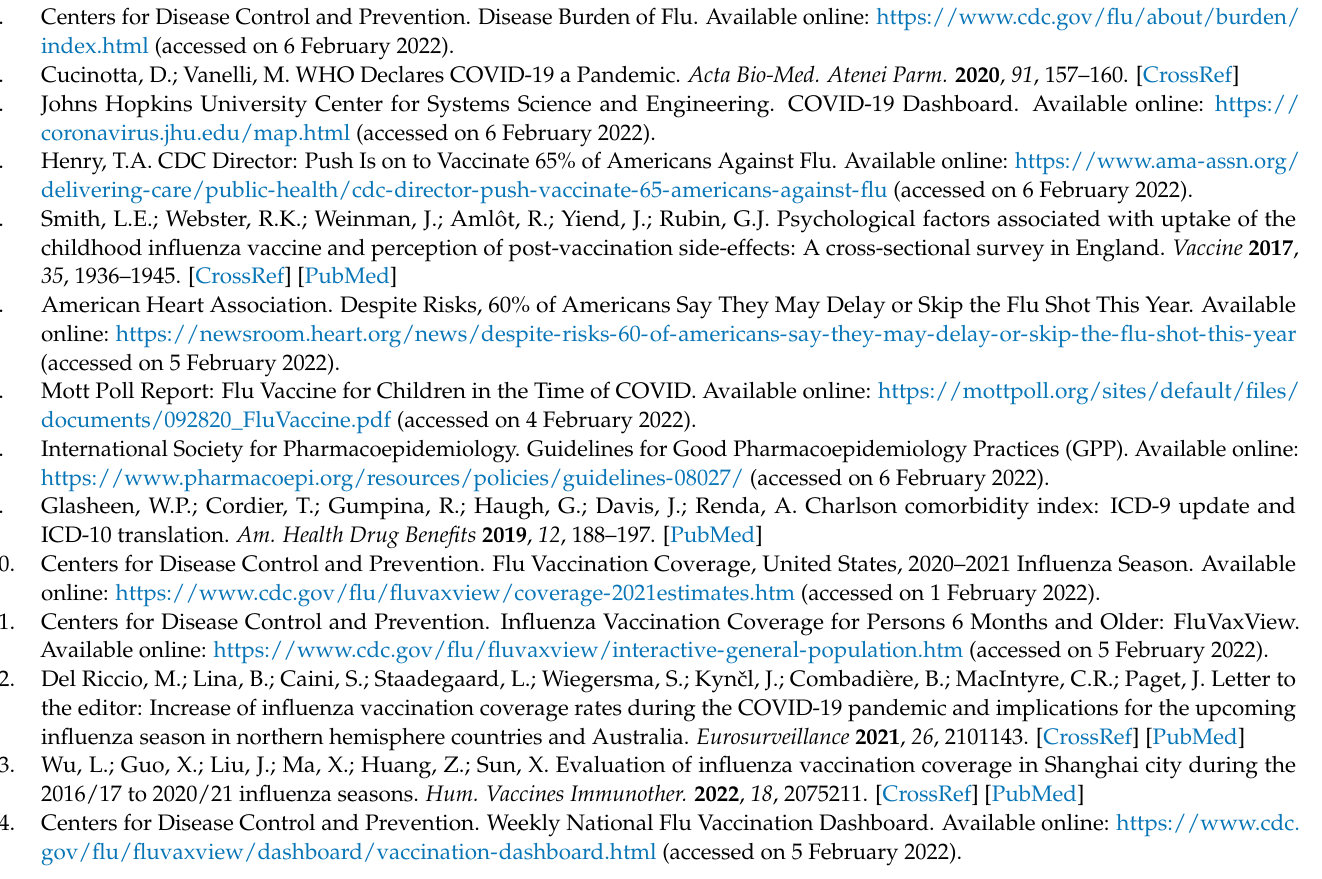
Table S9: Demographic and clinical characteristics of individuals continuously enrolled in the Linked Dataset according to vaccination status in 2020–2021; Table S10: Differences in patient